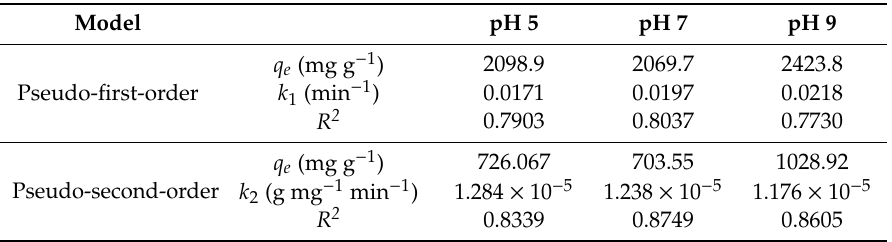
Table 3. Pseudo-first and pseudo-second-order kinetics parameters with di ff erent pH.